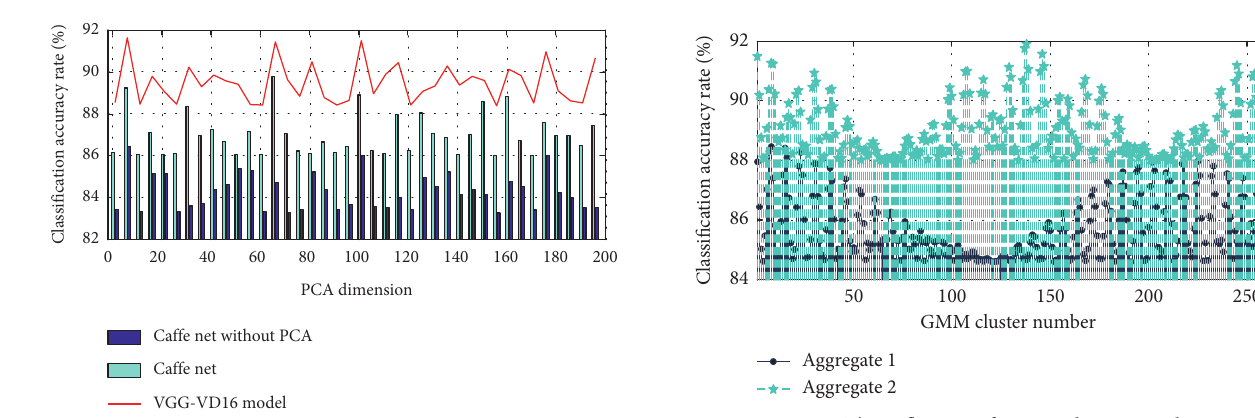
Figure 7: The impact of PCA transformation on “descriptive child aggregation.”